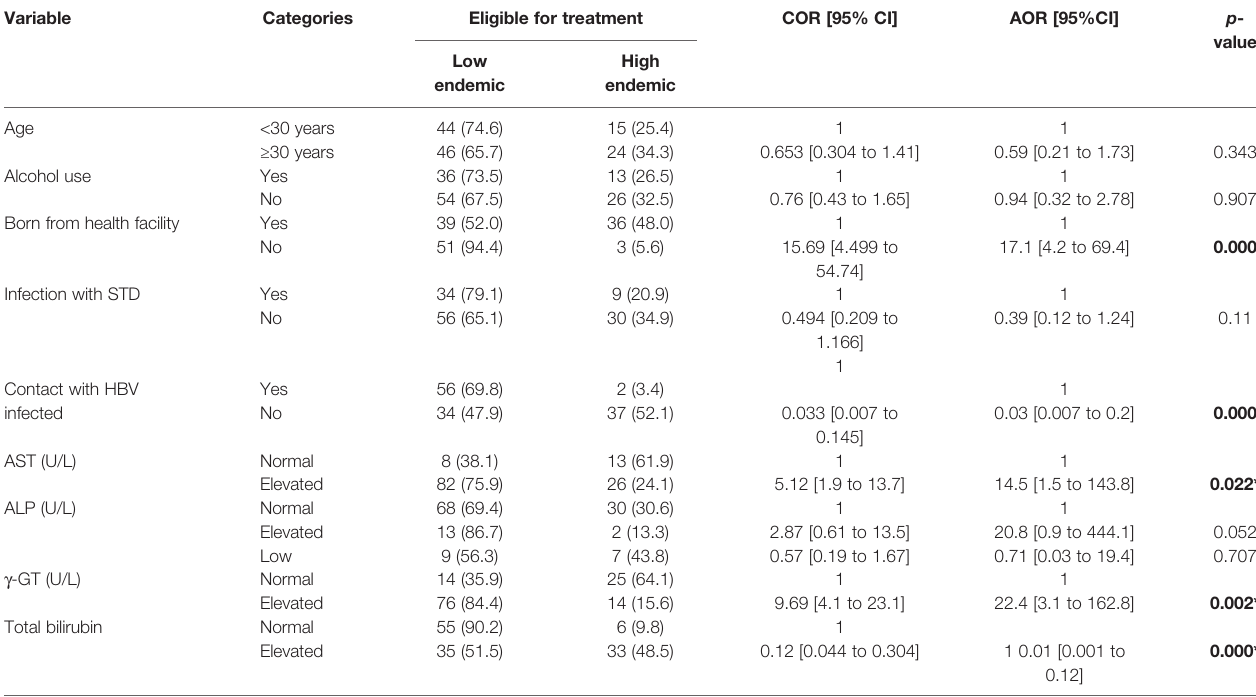
TABLE 5 | Socio-demographic factors and liver function tests associated with eligibility for treatment among the HBsAg seropositive participants from the low and high endemic regions.